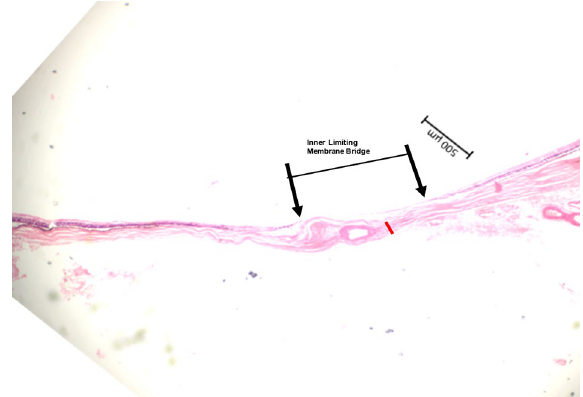
Figure 3. Histo-photograph showing the retina of an extremely elongated eye (axial length: 34.0 mm) with a region (between both black arrows) in which the retina consisted only of the inner limiting membrane (ILM) (“ILM-bridge”); length of the ILM-bridge: 1.04 mm; scleral thickness 110 µm (red bar): distance to the optic disc border: 3.72 mm.